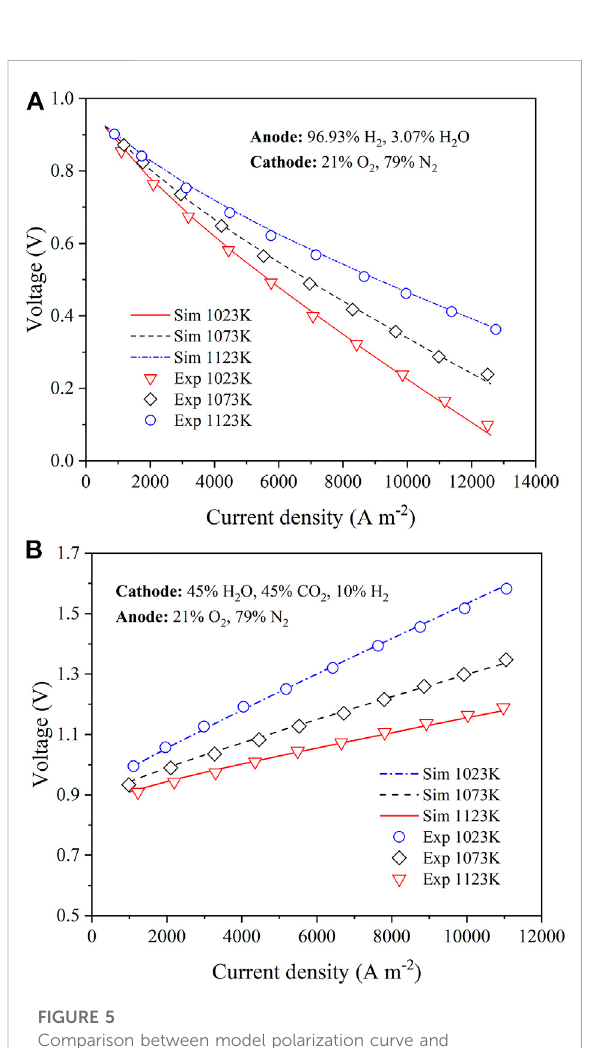
FIGURE 5 Comparison between model polarization curve and experimental polarization curve under different operating conditions (A) SOFC(Wu et al., 2018); (B) SOEC (Du et al., 2019). outlet pressure and energy loss. The comparison between the model results and the experimental data is performed in Figure 6A. It can be seen that the simulation results are in good agreement with the experimental data, and the proposed one-dimensional model of the ejector has good reliability.